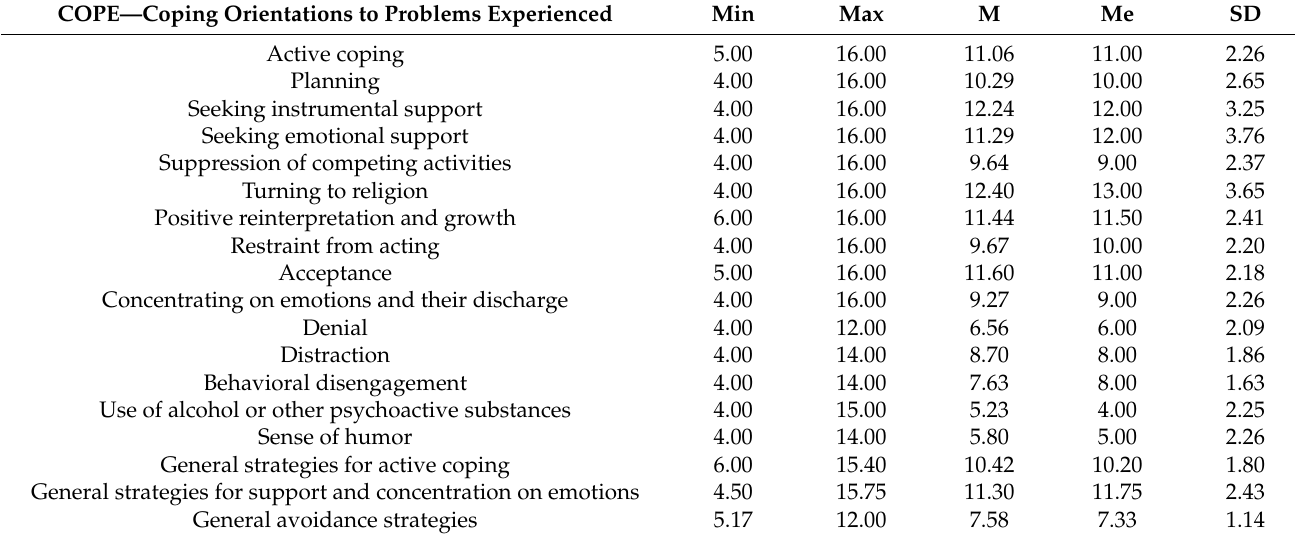
Table 1. Descriptive statistics of strategies of coping with disease as measured by